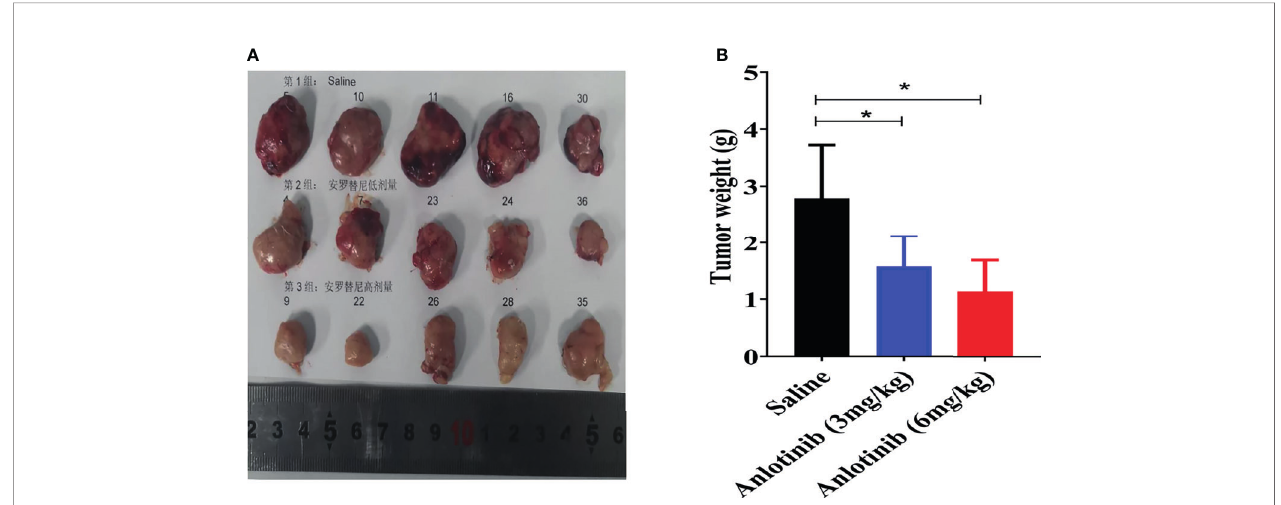
FIGURE 2 | The typical tumors harvested from mice sacri fi ced on the last day of experiment. (A) The photographs of tumors on the fi nal day. (B) Tumor weight of different groups. *p < 0.05.